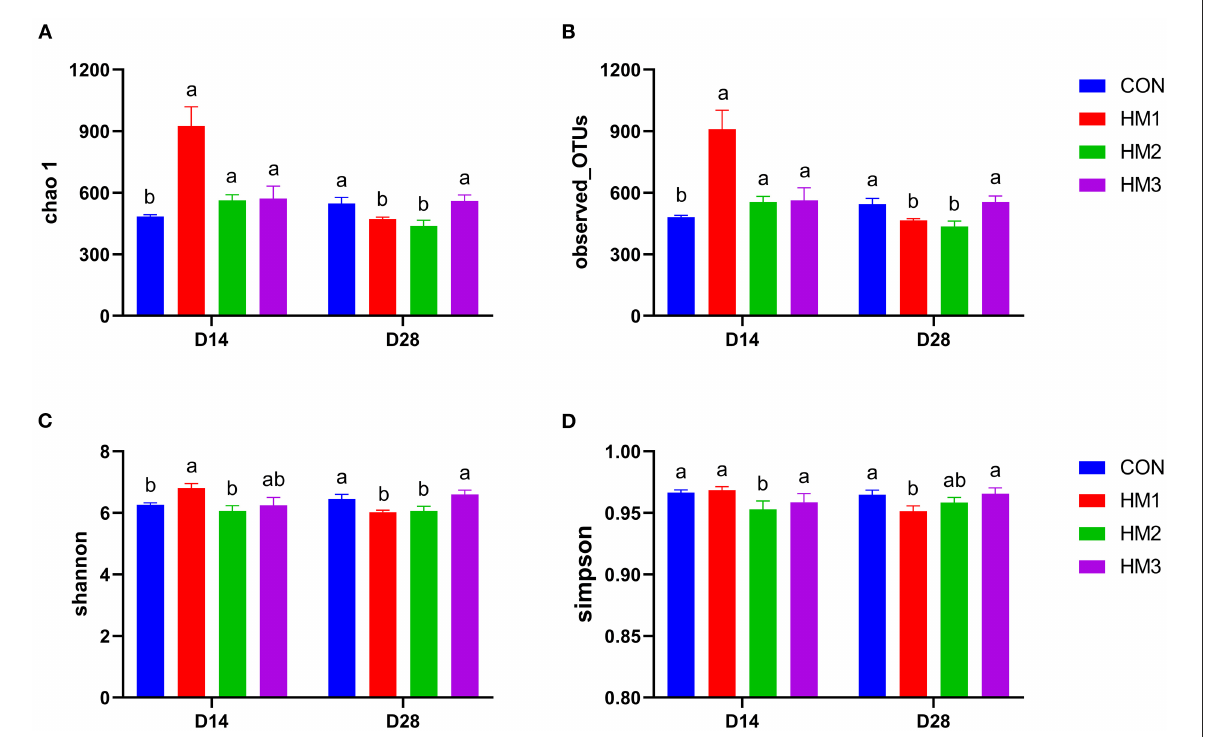
FIGURE1 Effects of herbal mixture on the intestinal microbiota diversity in weaned pigs on day 14 and day 28 based on alpha diversity parameters of chao1 index (A) , observed OTUs (B) , shannon index (C) and simpson index (D) . The X-axis is the experimental period, and the Y-axis is the diversity indexes. CON, basic diet; HM1, basic diet with 0.5 g/kg of herbal mixture; HM2, basic diet with 1.0 g/kg of herbal mixture; HM3, basic diet with 1.5 g/kg of herbal mixture. Different lowercase letters in the figure indicate statistically significant differences ( p <